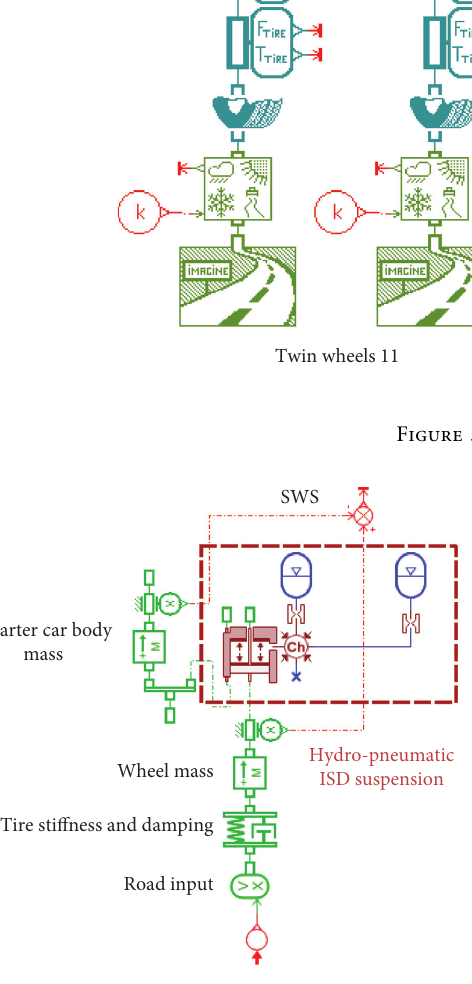
Figure 6: Hydro-pneumatic ISD suspension model.